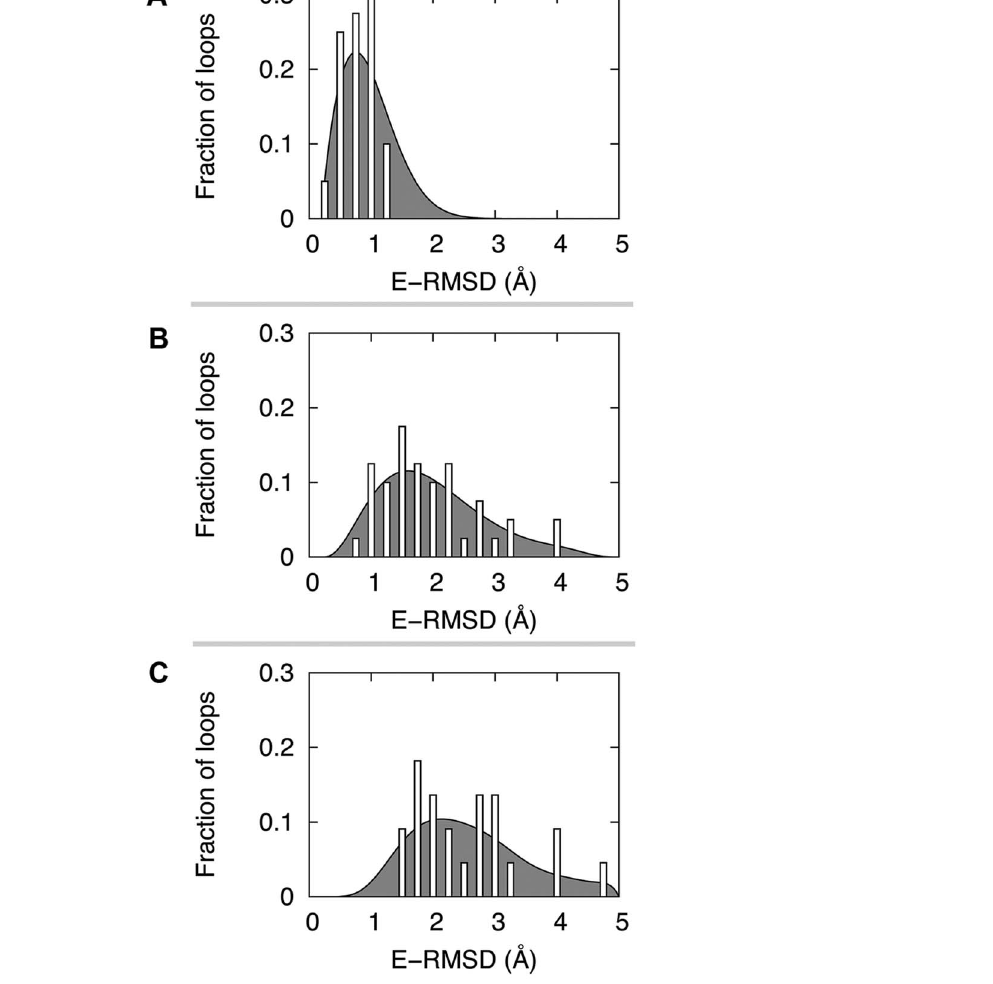
Figure 1. Distributions of environmental errors for the three types of test sets employed in the study. (A) for the test set of crystal structures with perturbed side chains, (B) for the crystal structures with both backbone and side chains perturbed, and (C) for the template-based models. The gray curve behind the histogram represents an interpolation. The average E-RMSD values are 0.9 A˚, 2.1 A˚, and 2.8 A˚ for the side chain-perturbed set (A), the backbone-perturbed set (B), and the template-based model set (C), respectively. E-RMSD represents the all-atom RMSD of environment residues for which any atoms are within 10 A˚ from any loop C b